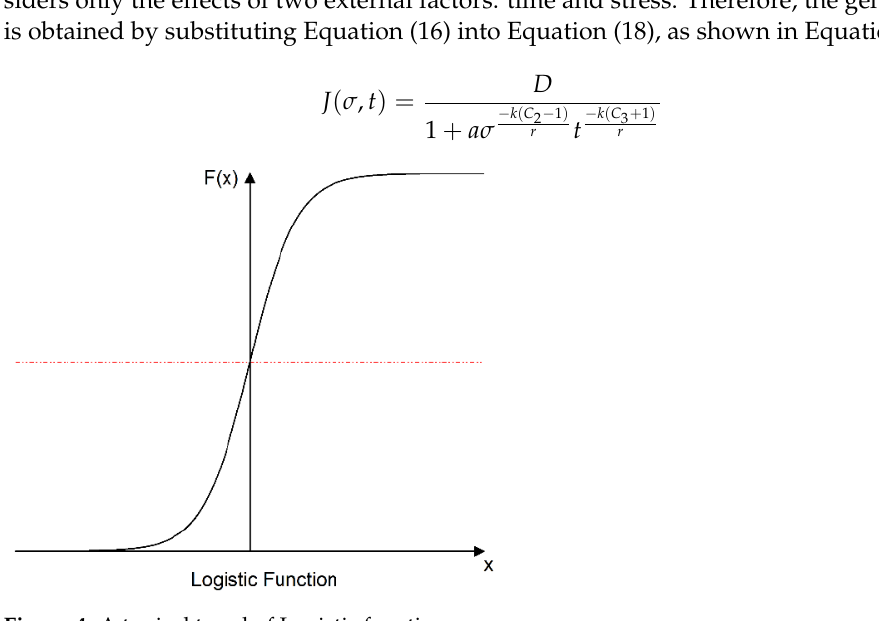
Figure 4. A typical trend of Logistic function.